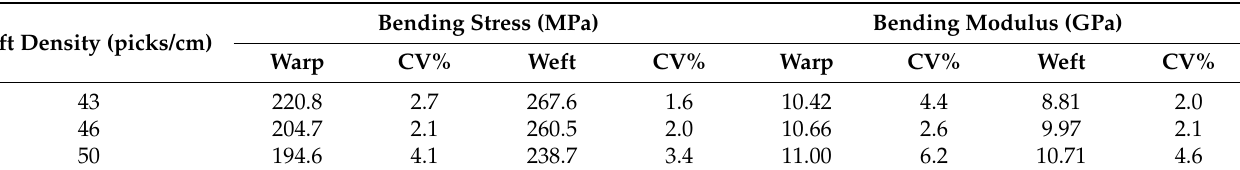
Table 7. The bending properties of materials with different weft densities.